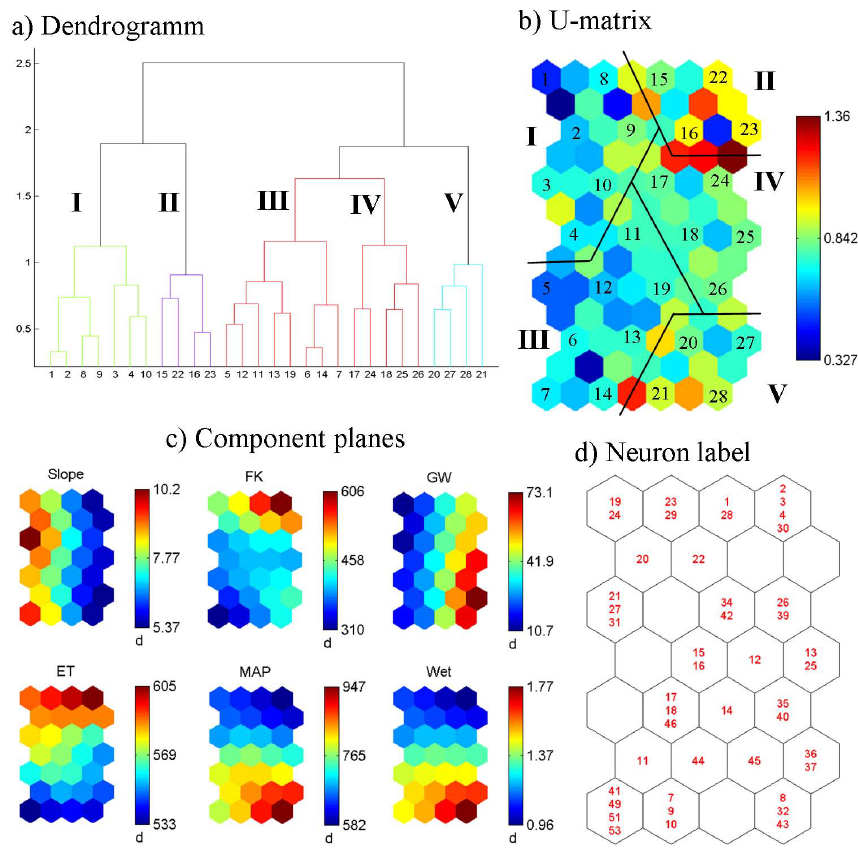
Fig. 8. SOM and clusters by physical catchment properties. (a) Dendrogram of SOM indicates cluster I to V, (b) unified distance matrix with neurons indicated by numbers and clusters; shows structures by visualising distances between neighbouring neurons and, on additional hexagons, median distances between two neurons. (c) Component planes for each index display mean values of the index onto the neurons of the SOM. (d) Assignment of catchments to neurons labels catchment IDs to their corresponding BMU1. In each figure, a certain position corresponds to the same